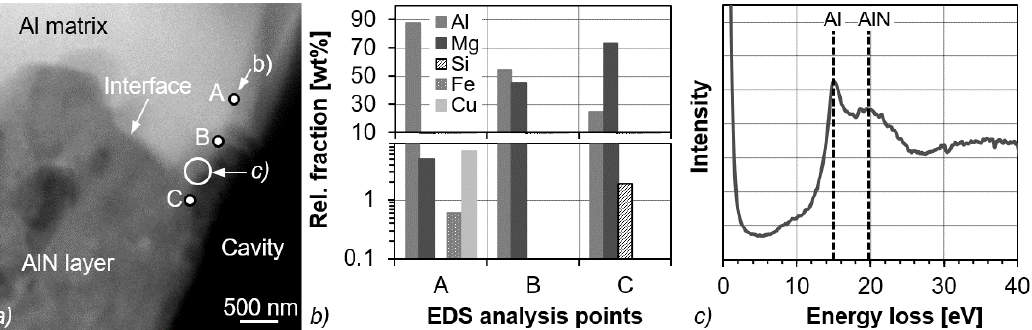
Figure 7. Analysis of the interface between the AlN layer and the Al base material: ( a ) TEM image (df) with measuring points of: ( b ) EDS analysis (point A – C); ( c ) low-loss area of the EEL spectrum. (df) with measuring points of: ( b ) EDS analysis (point A–C); ( c ) low-loss area of the EEL spectrum.